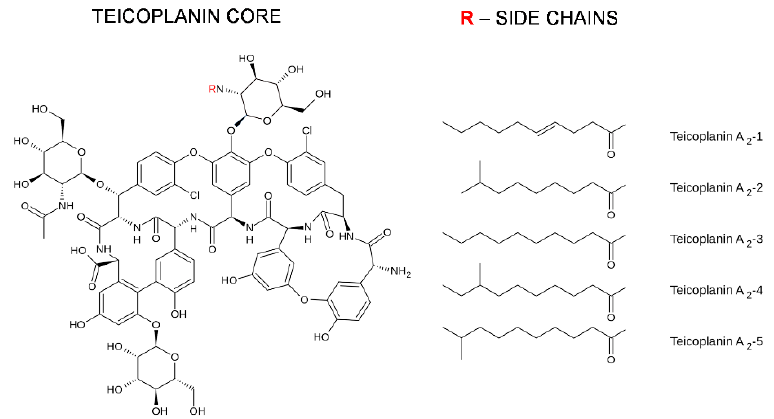
Figure 1. Chemical structure of teicoplanin.